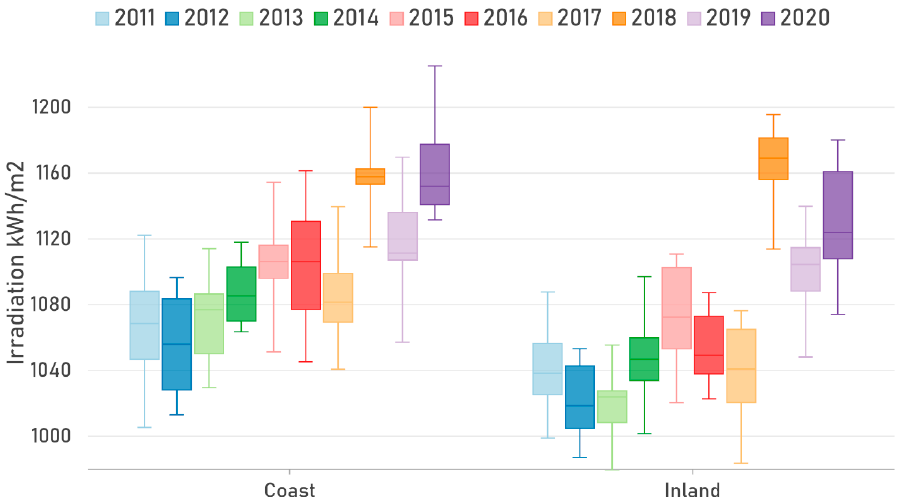
Figure 4. The range of irradiation values for all 30 stations categorized as coast (east) and inland (located west from the coast) for 10 years. Extremely high values were observed in the last 3 years, with record highs above 1200 kWh/m 2 for a few stations on the coast. The East to West variation of irradiation in the Netherlands can also be inferred from the graph.